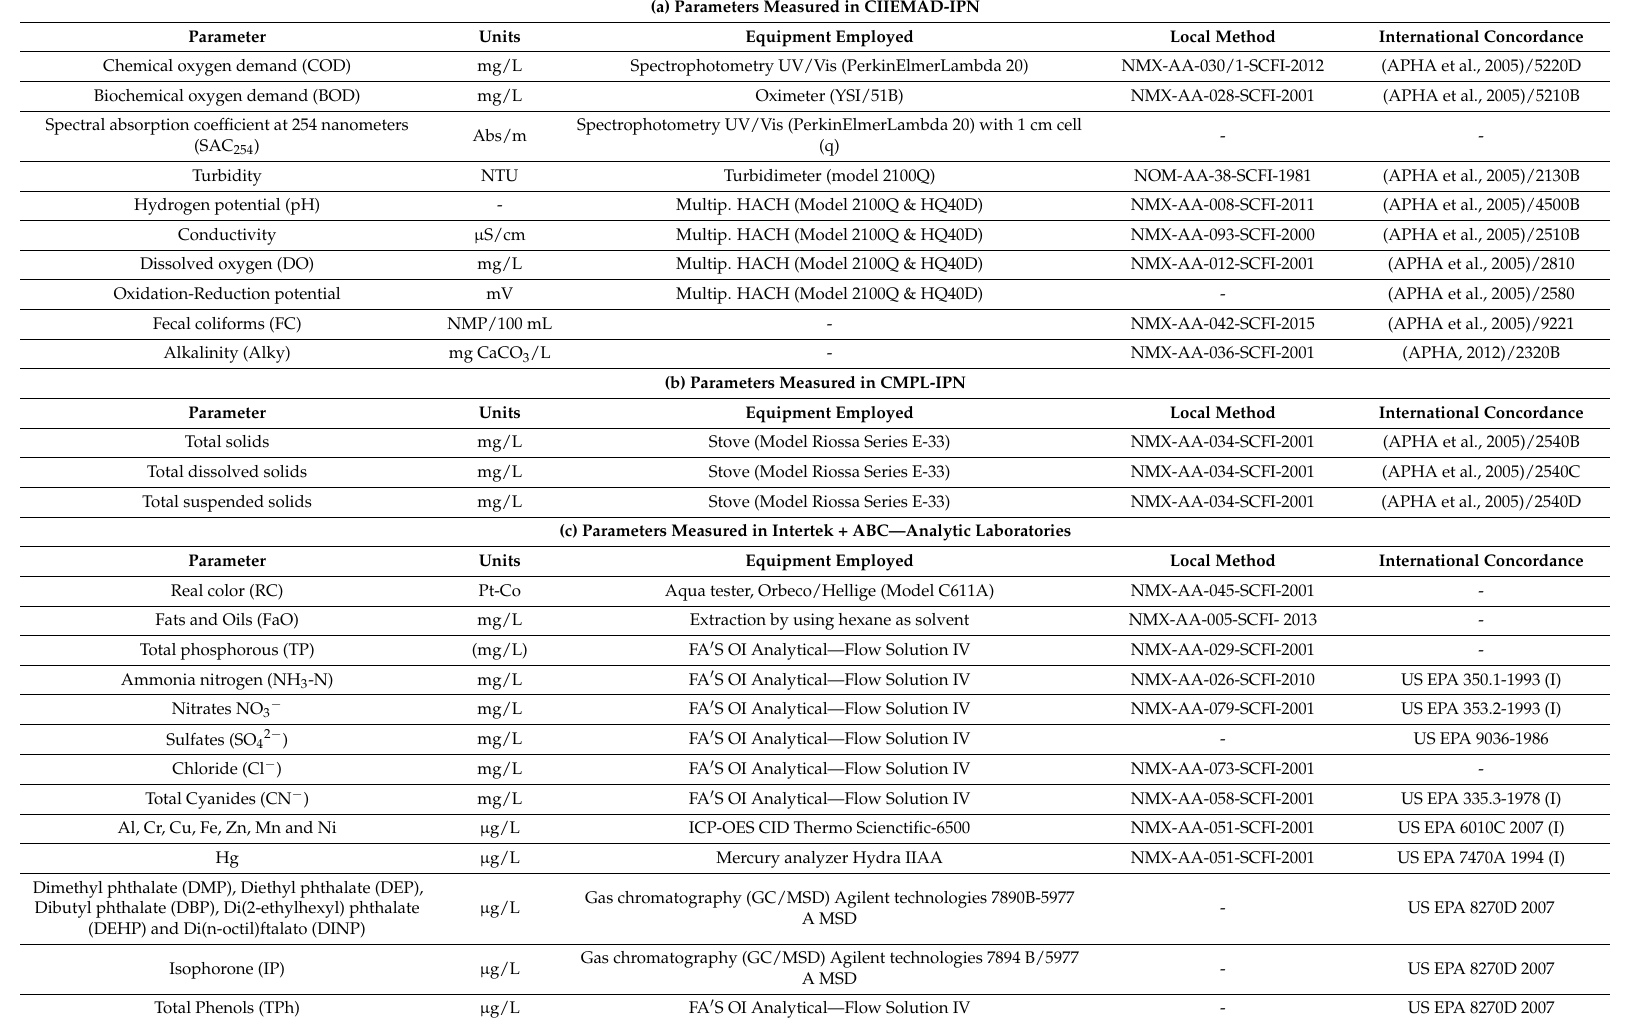
Table 1. Methods employed to measure physicochemical parameters and their International